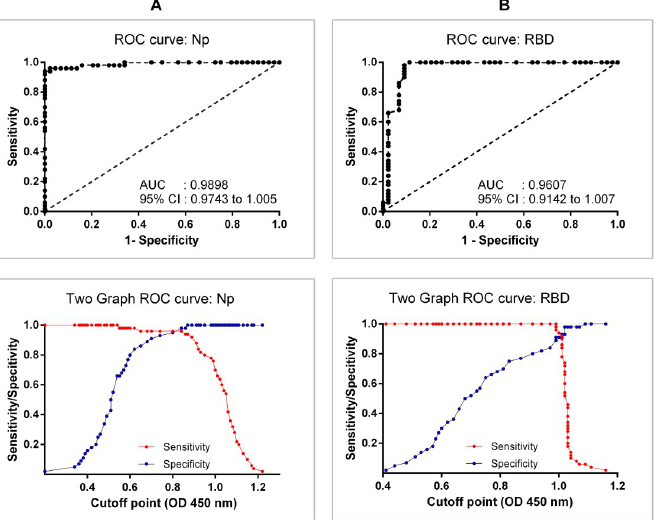
Fig 2. Receiver operating characteristic (ROC) curves for the combined detection of SARS-CoV-2 IgA, IgM, and IgG immunoglobulin isotypes using RBD or Np antigens. Graph of ROC curve and two graph curves (sensitivity and specificity for different cut-off) for Np-specific immunoglobulins (Panel A: top and bottom, respectively), and RBD-specific immunoglobulins (Panel B: top and bottom, respectively), are shown. Forty-four sera from pre- pandemic individuals and fifty sera from COVID-19 patients were tested. AUC, area under the curve of ROC.